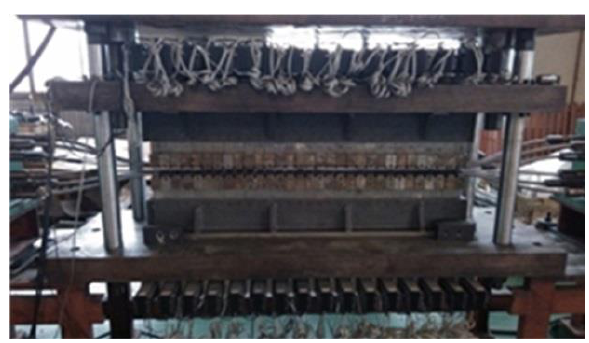
Figure 11. Experimental equipment for continuous roll forming.